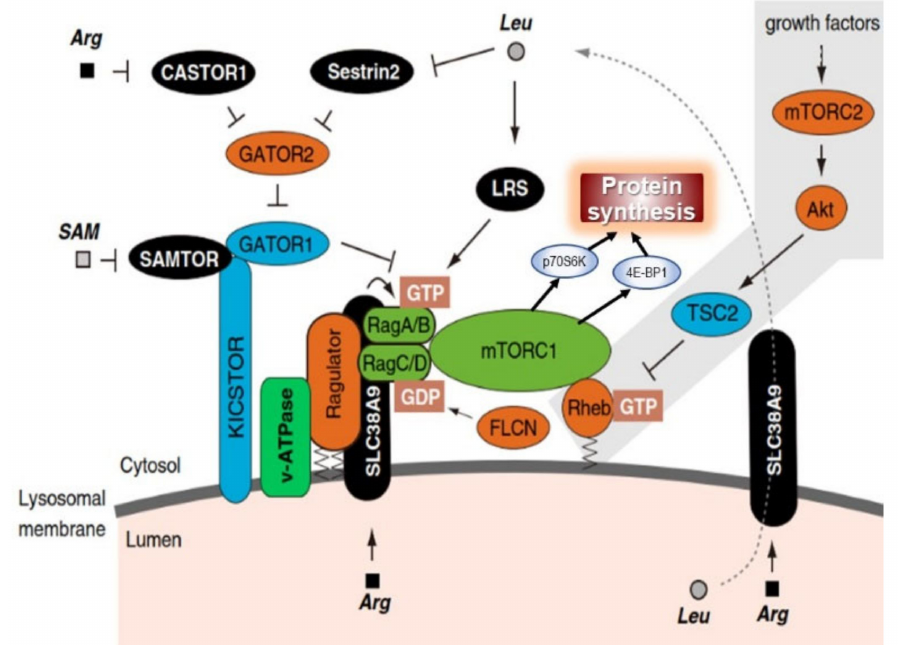
Figure 13. Consensus model of amino acid-dependent mTORC1 activation at the lysosome [306]. Leucine (Leu), arginine (Arg), and S-adenosylmethionine (SAM) are sensed by cytosolic and lyso- somal sensors, Sestrin2, CASTOR1, and SAMTOR, (S-adenosylmethionine sensor upstream of mTORC1), as well as LRS, (leucyl-tRNA synthetase 1) and SLC38A9, (essential amino acids trans- porter). These signals relieve inhibitory signalling and converge on Rag GTPases (heterodimeric RagA/B-RagC/D GTPases, members of a subfamily of the Ras-like small GTPase superfamily), which recruit mTORC1 onto the lysosomal surface. There mTORC1 is activated by association with the Rheb, (Ras homolog enriched in brain), GTPase. The efflux of leucine from the lysosomal lumen to the cytosol through the arginine-sensitive SLC38A9 transporter also activates mTORC1 via cytosolic sensors. Activated mTORC1 signals an increase in protein synthesis through p70S6K